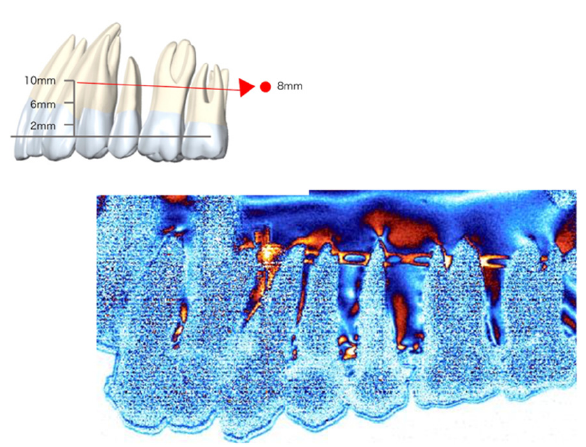
Figure 10. Ten-millimeter retraction hook and 8 mm positioned posterior anchor